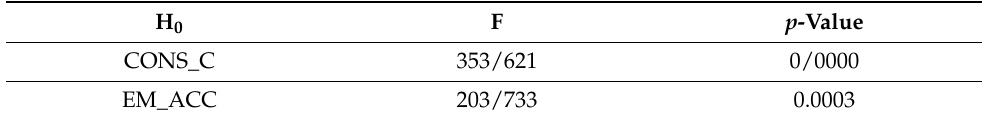
Table 8. Granger causality